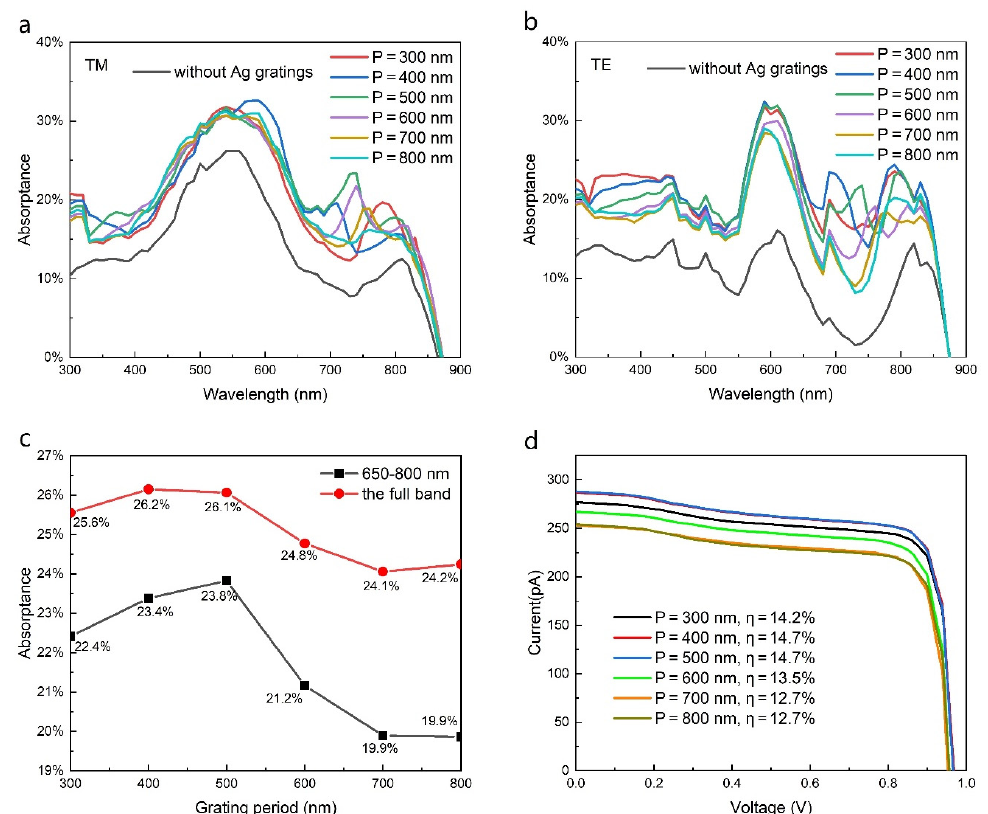
Figure 4. ( a , b ) The absorptance of the laterally oriented NWs with different period gratings for TM and TE polarized light, respectively. ( c ) The AM 1.5 G-weighted integral of the NW absorptance with different grating periods. ( d ) The current–voltage characteristics of the NWs with different grating periods. All widths of the grating grooves are half of the grating periods, and the diameter of NWs is 180 nm.